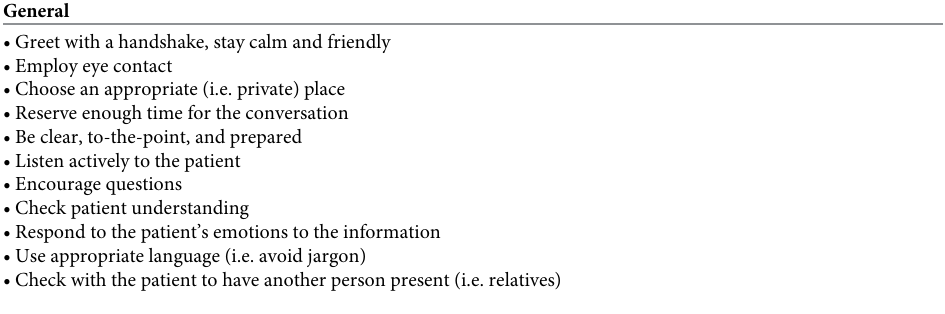
Table 2. Recommendations for physicians for discussions about prognosis and end of life.